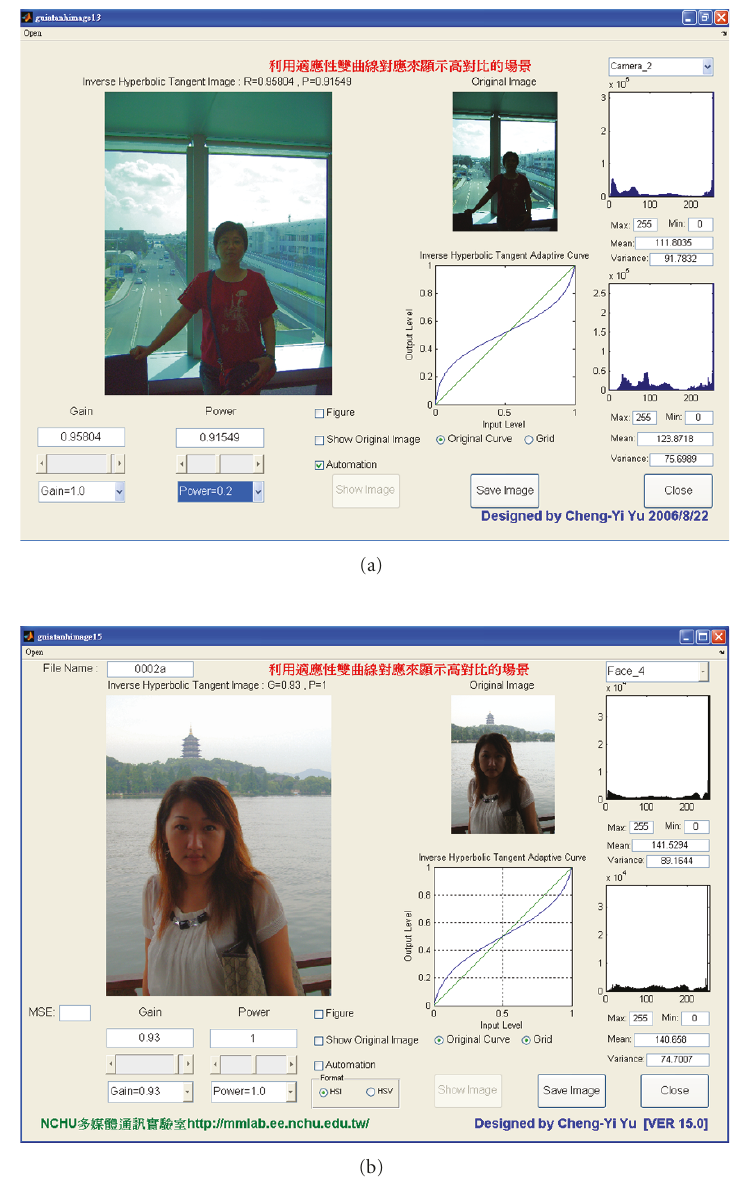
Figure 22: The user interface of the AIHT system: (a) automatic mode, (b) manual mode.